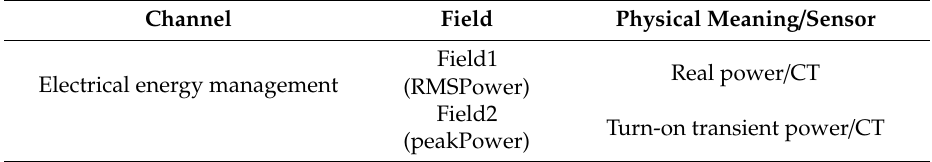
Table 2. Field of RMSPower and peakPower (turn-on transient power consumption) in ThingSpeak TM